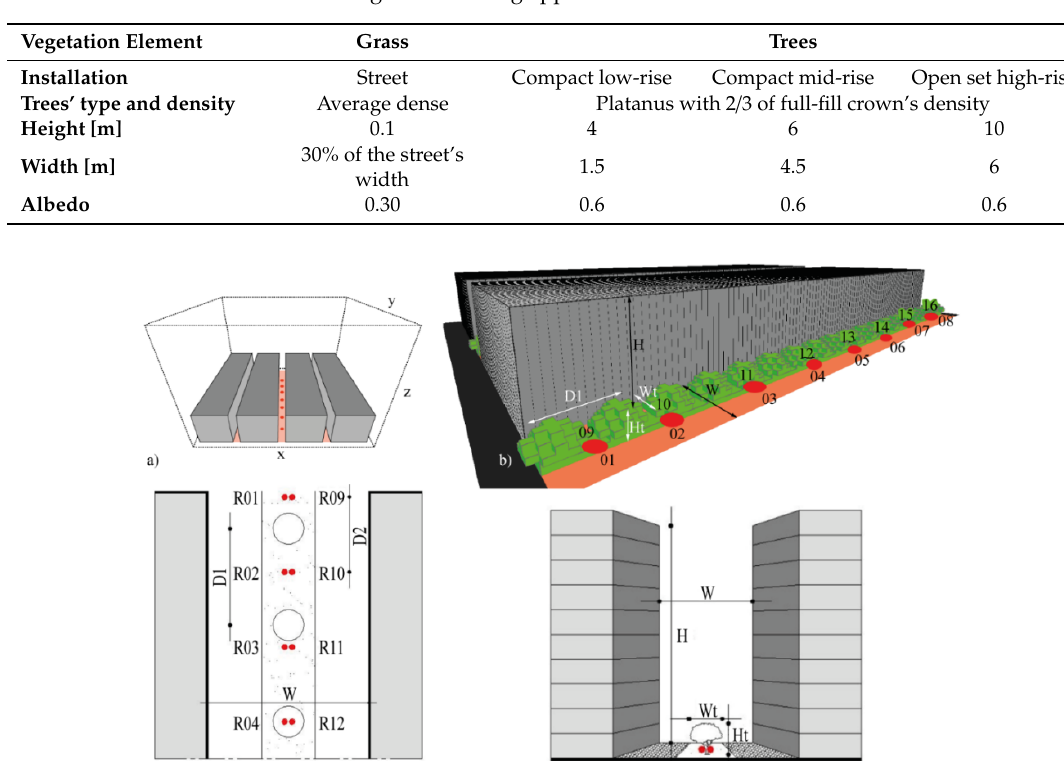
Figure 3. 3D model of the four blocks and three UCs in the spatial (x, y, z) domain ( a ), view of a street ( b ), horizontal ( c ) and vertical ( d ) sections. The receptors (red points), trees’ location and distance between trees (D 1 ) and receptors (D 2 ) are visualized.